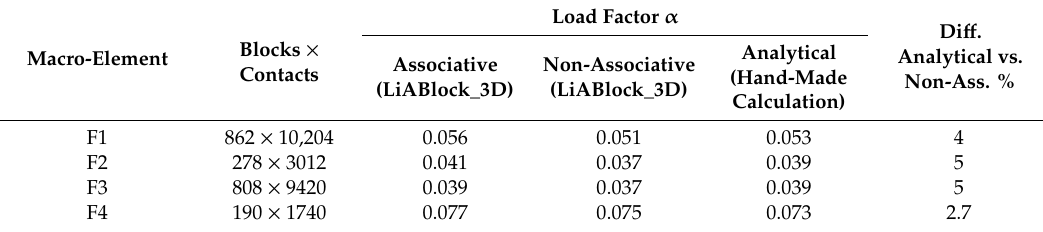
Figure 9. Block sizes (front views) for the sensitivity analysis.